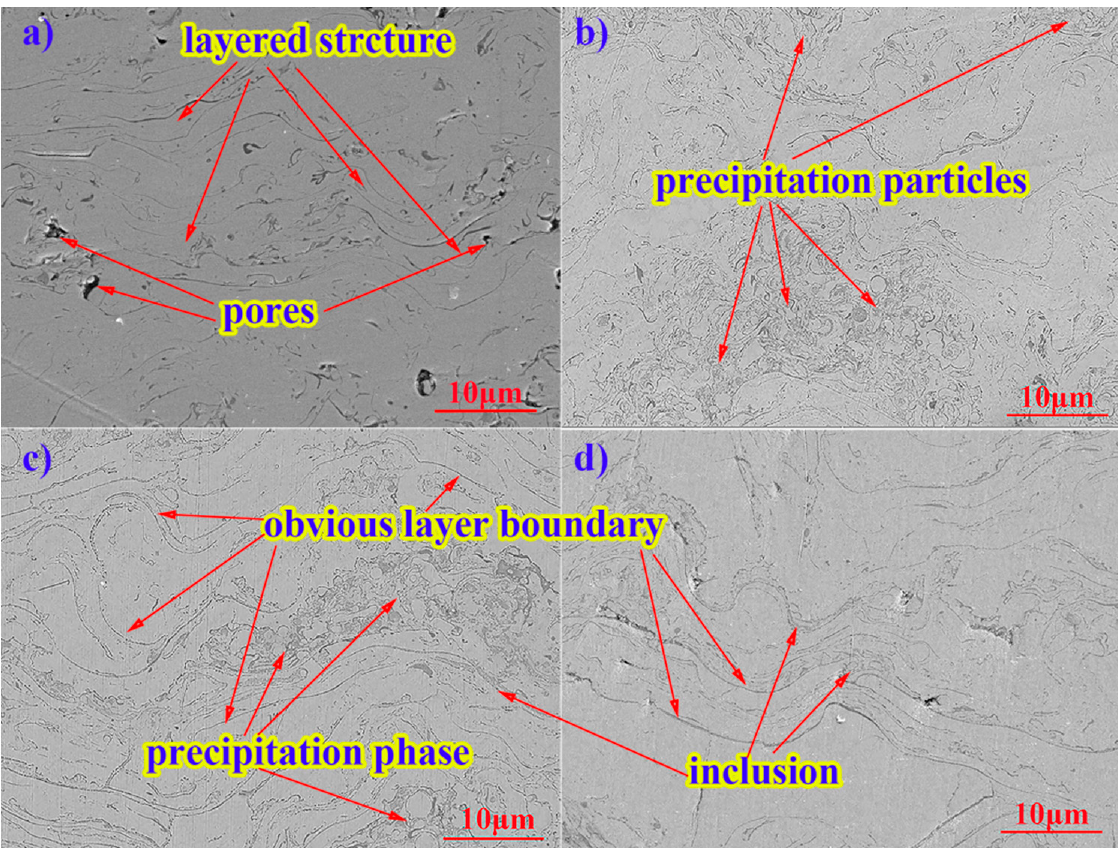
Figure 4. Cross-sectional images of as-sprayed CoMoCrSi coating ( a ) and coatings annealed for 3 h ( b ), 5 h ( c ), and 10 h ( d ).